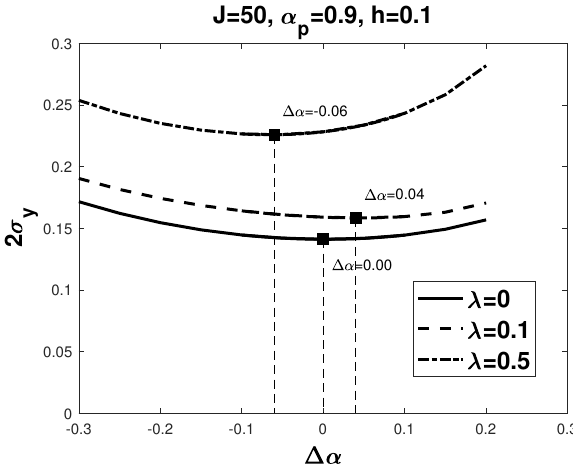
Figure 11. 2 σ y against ∆ α with limits on the control